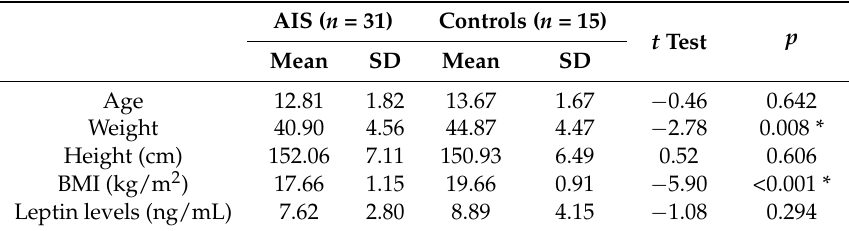
Table 1. Anthropometrics and total serum leptin levels in the AIS patients and controls. AIS ( n = 31) Controls ( n = 15)